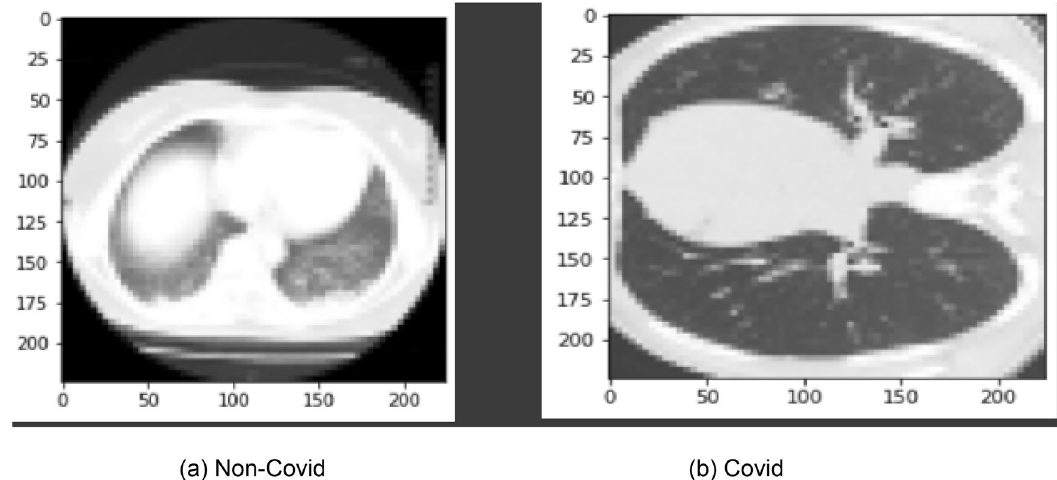
Figure 6. Covid and Non-Covid prediction.